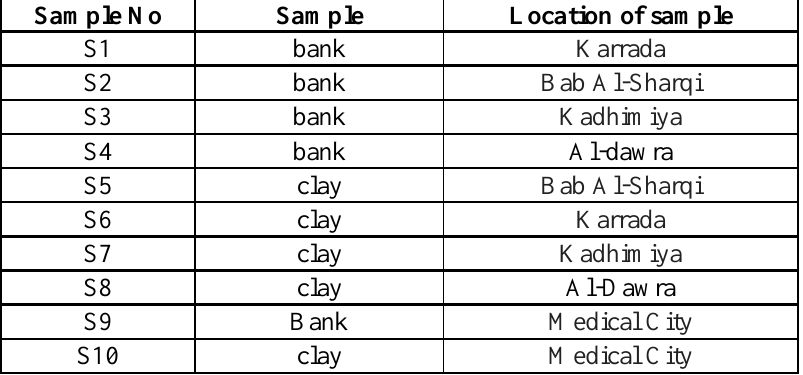
Table 1: The local soil samples taken from Tigris river